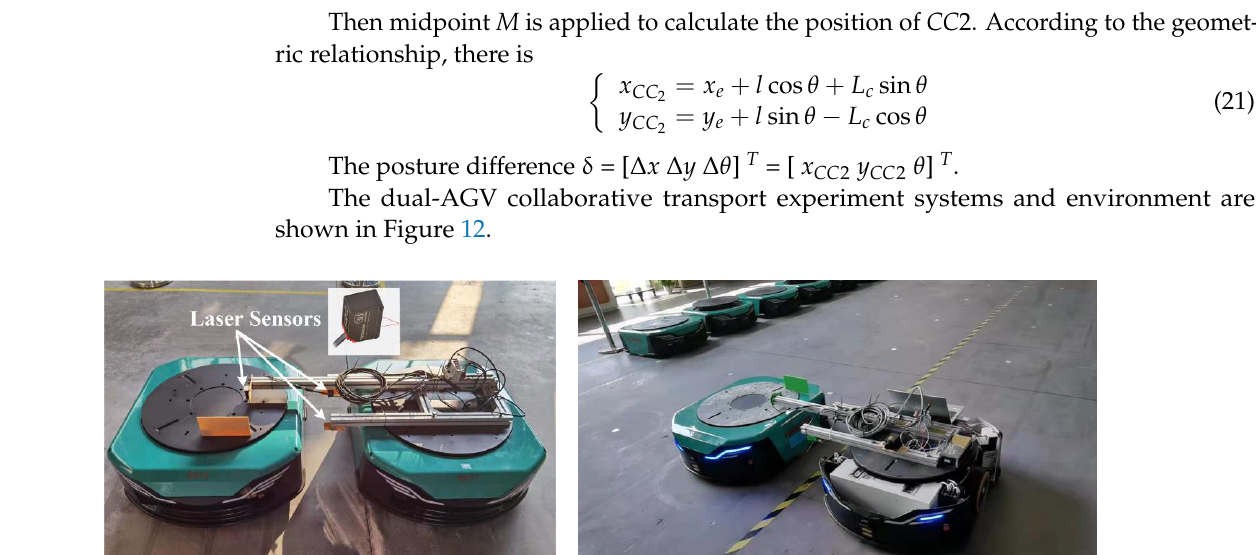
1200 mm. Network parameters are shown in Table 1. In the formation algorithm, k 1 = 0.1,